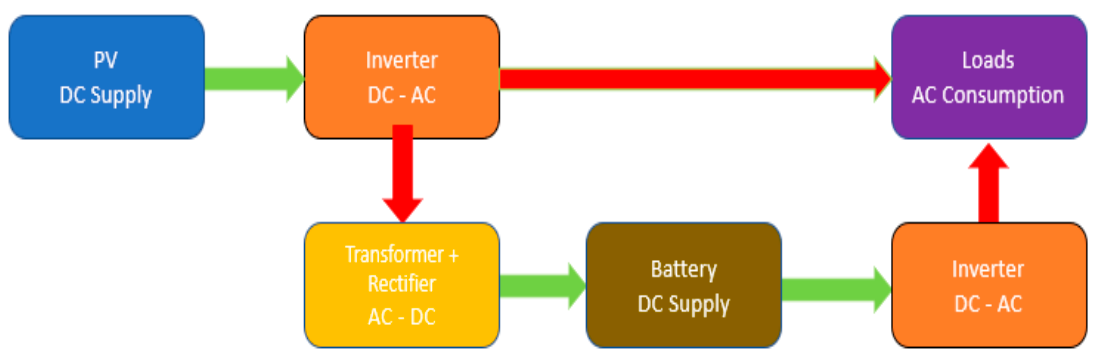
Figure 5. Current industry practice in implementing PV + Battery systems.